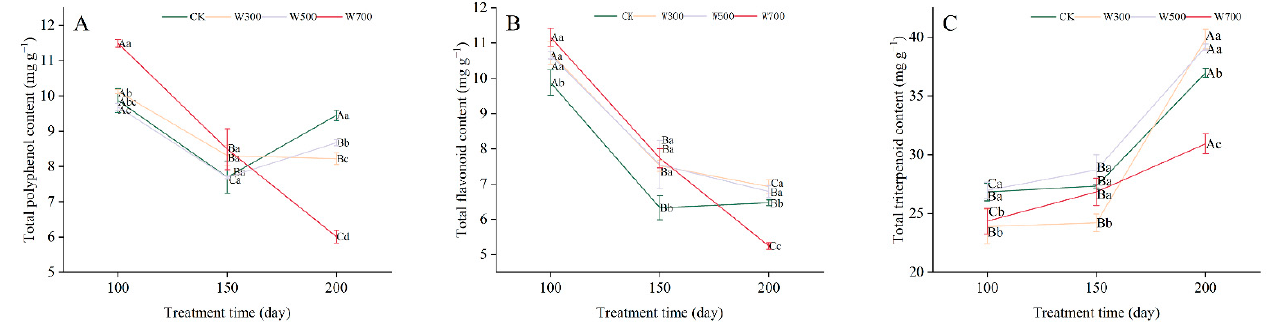
Figure 6. Effects of biochar pyrolyzed at different temperatures on the total contents of polyphenols ( A ), flavonoids ( B ), and triterpenoids ( C ) in the leaves of C. paliurus at 100, 150 and 200 days after treatment. CK: without biochar; W300: with biochar pyrolyzed at 300 °C; W500: with biochar pyrolyzed at 500 °C; W700: with biochar pyrolyzed at 700 °C. Different uppercase letters represent significant differences among the different sampling times in the same treatment, while different lowercase letters indicate significant differences among different treatments at the same sampling time according to Duncan’s test ( p < 0.05), respectively.